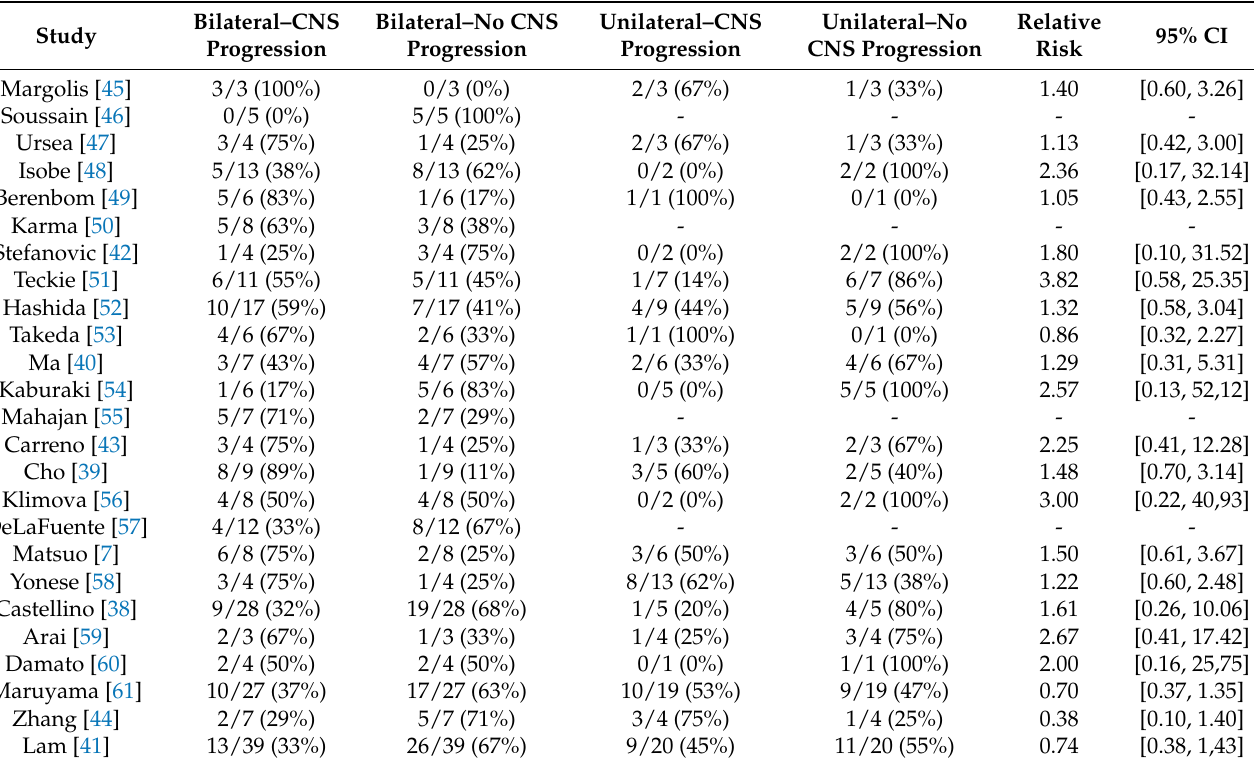
Table 3. Relative risk of CNS progression for PVRL with bilateral involvement compared to PVRL with unilateral involvement. RR > 1 suggests higher risk of CNS progression in cases with bilateral involvement; RR < 1 suggests higher risk for unilateral cases.